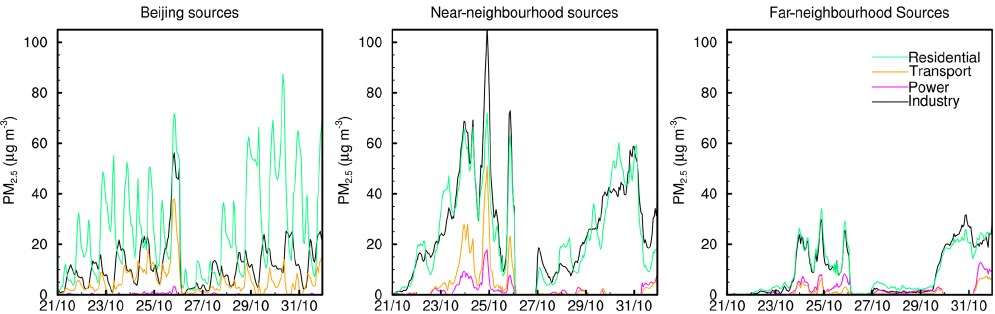
Figure 6. Contribution of residential, transport, power, and industry emission sectors from local, near-neighbourhood, and far-neighbourhood source regions to PM 2 . 5 concentrations in Beijing during 21–31 October 2014.